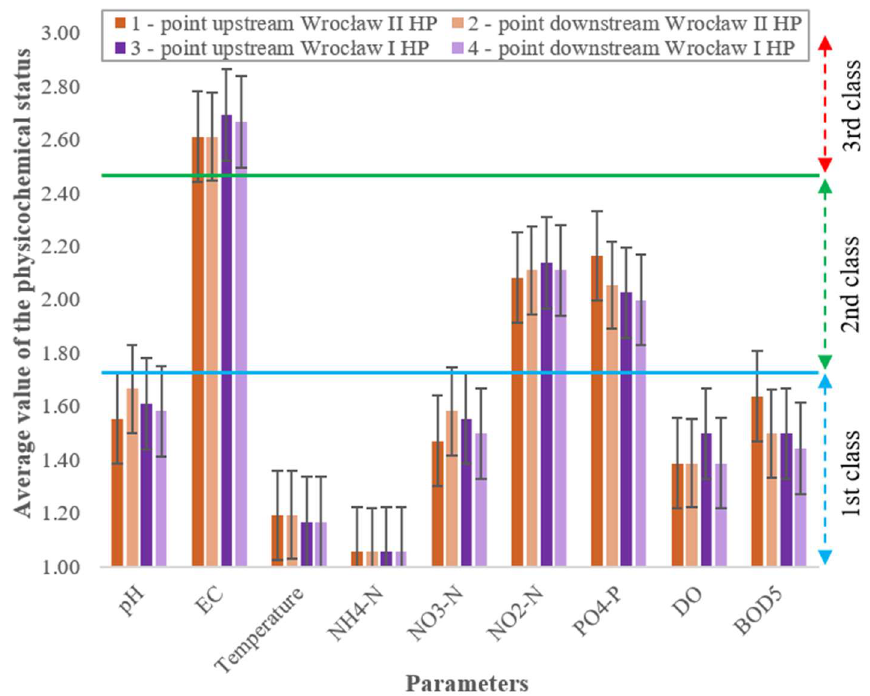
Figure 2. Average physicochemical status for the tested parameters within the Wrocław I and Wrocław II hydropower plants (HPs).